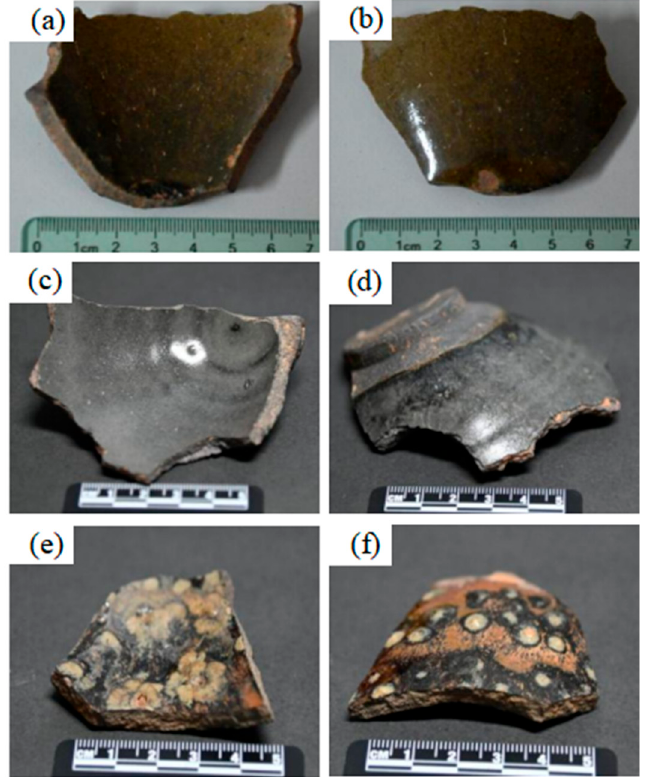
Figure 1. Practical photos of the three analyzed samples: ( a , b ) JZ-07, tea-dust-glazed porcelain; ( c , d ) JZ-16, grey-glazed porcelain; ( e , f ) JZ-14, pearl-glazed porcelain.